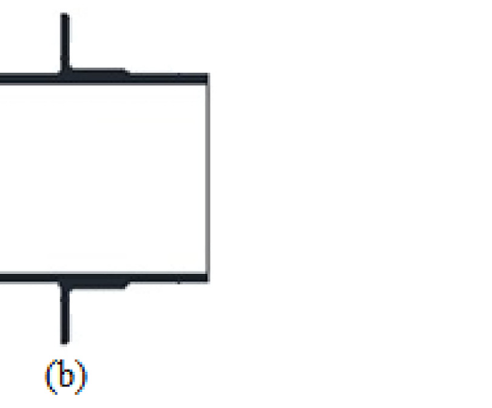
Fig 1. C-shaped angle connectors (a) and L-shaped angle connectors